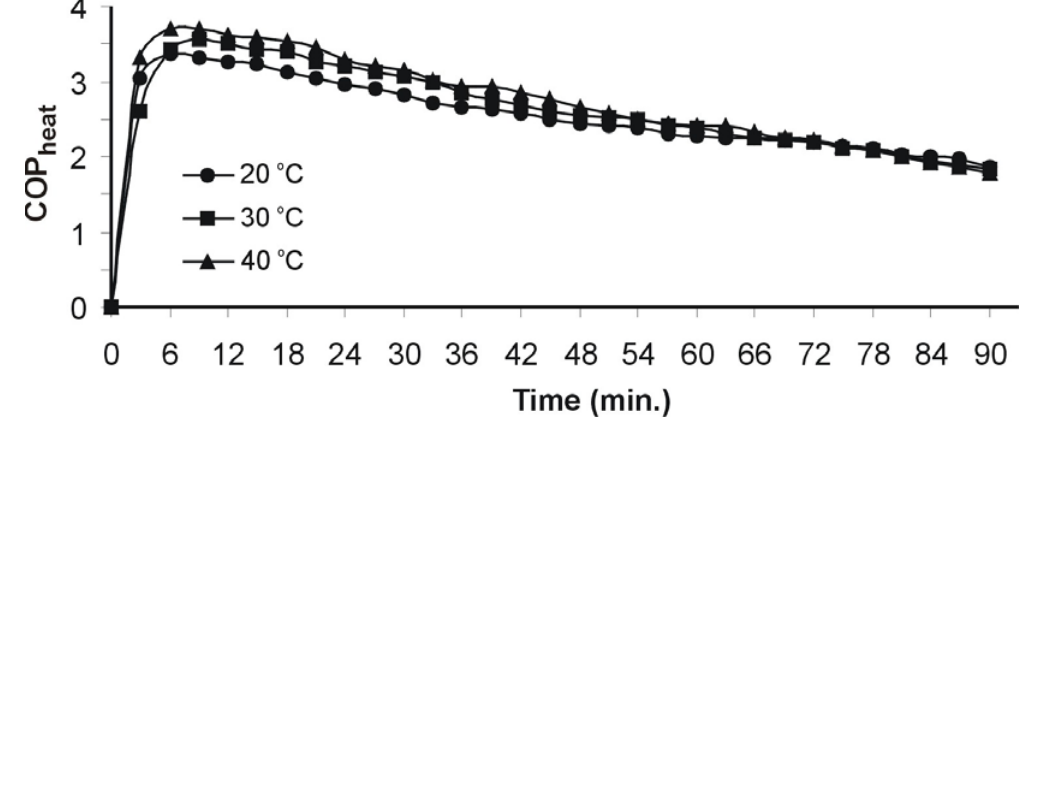
Figure 9. The variation of the heating coefficients of performance at the different waste water temperatures for the circulation pump flow rate CP I during the